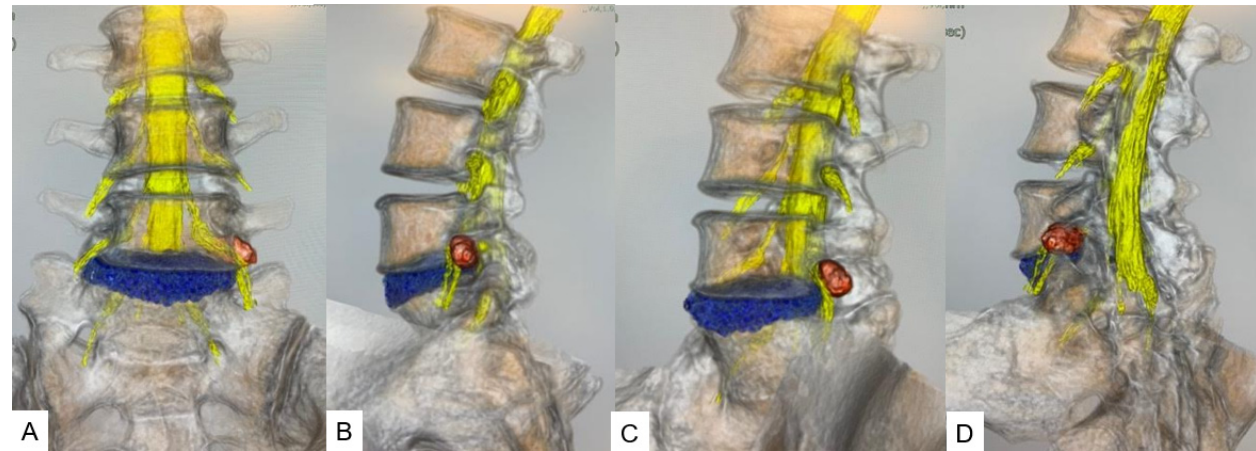
Figure 7. A 46-year-old male, left L5/S1 foraminal/extraforaminal disc herniation. ( A ): Anterior view. ( B ): Lateral view. ( C ): Anterior oblique view. ( D ): Posterior oblique view.